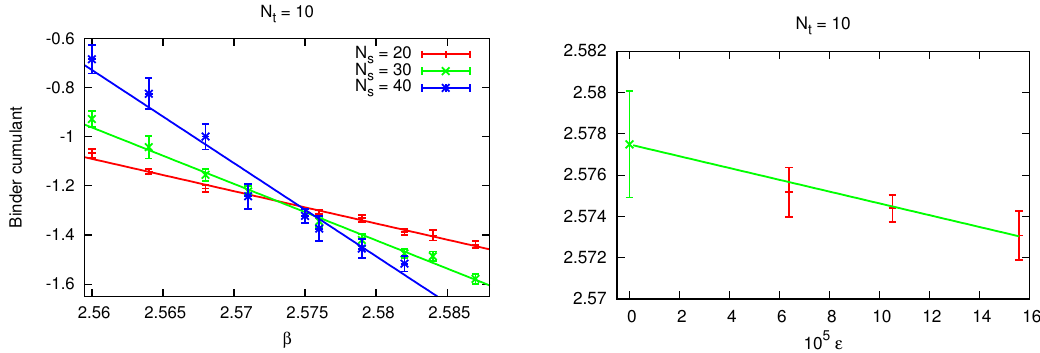
Figure 4 . Binder cumulants and in(cid:12)nite volume extrapolation of the critical coupling with the Wilson plaquette action at N t =